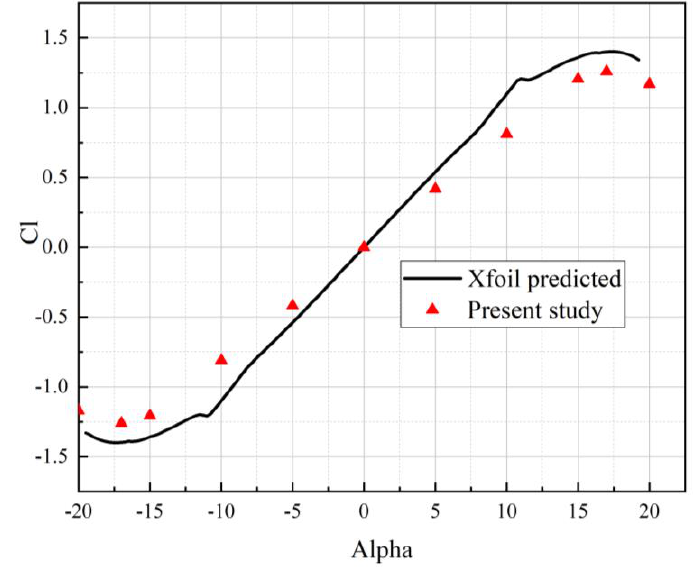
Figure 14. NACA0018 airfoil lift coe ffi cient (angle of